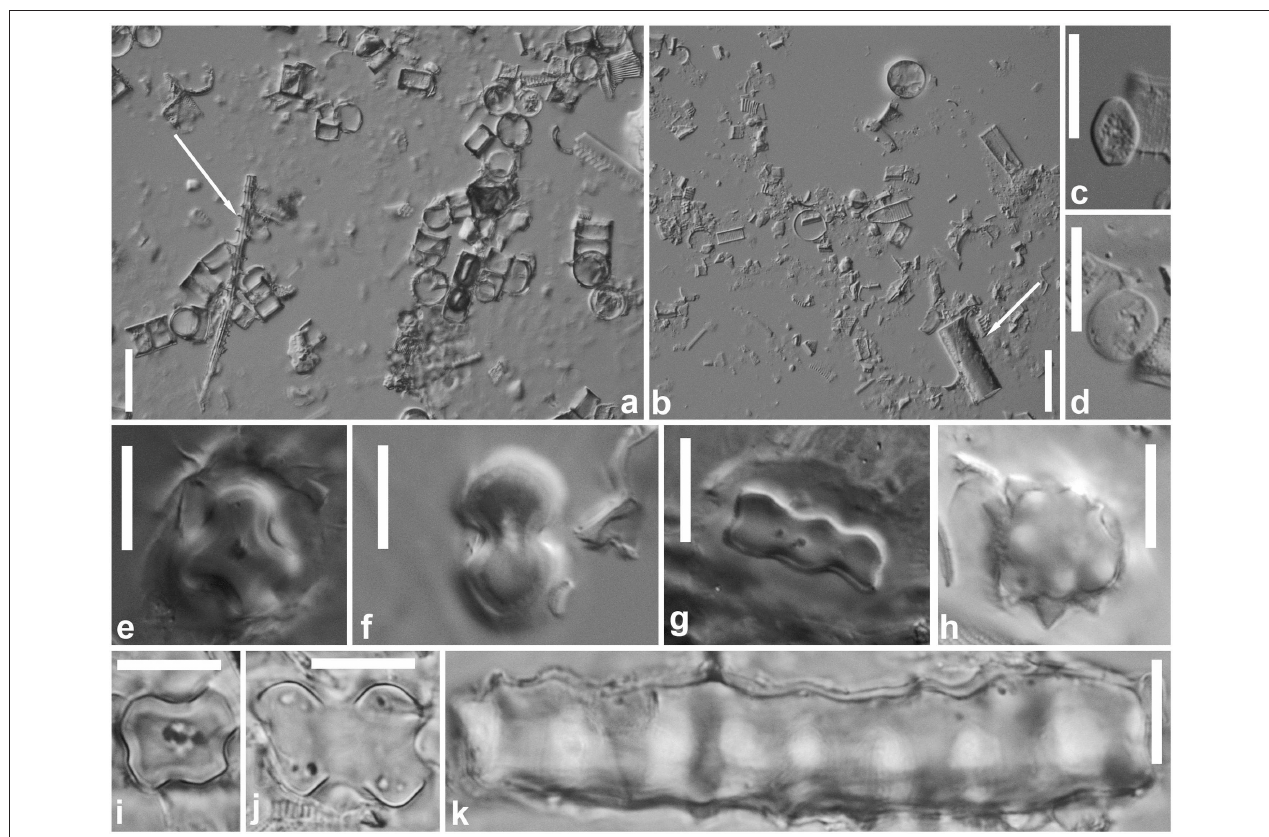
FIGURE 4 | Silica particles in the sediment and plant samples. Sediment samples originate from Kodjoboue lagoon, and are exemplary to all examined samples from the three lagoons. (a) Large number of diatom valves, mainly belonging to the genus Aulacoseira and one sponge spicule (megasclere, see arrow). (b) Shows a few broken diatom valves and one phytolith (see arrow). Plant samples originate from dominant plant species from across all three lagoons. (c,d) Show testate amoeba idiosomes. (e–h) Show different phytoliths found in Echinochloa pyramidalis samples: short cell bilobate (e,f) , cylindrical polylobate (g) , and globular echinate (h) phytoliths were observed. (i–k) Show different phytoliths found in a Panicum parviflorum sample: short cell cross (i) , short cell bilobate (j) , and long cell echinate (k) phytoliths were observed. Scale bar represents 20 µ m for panels (a,b) and 10 µ m for panels (c–k)